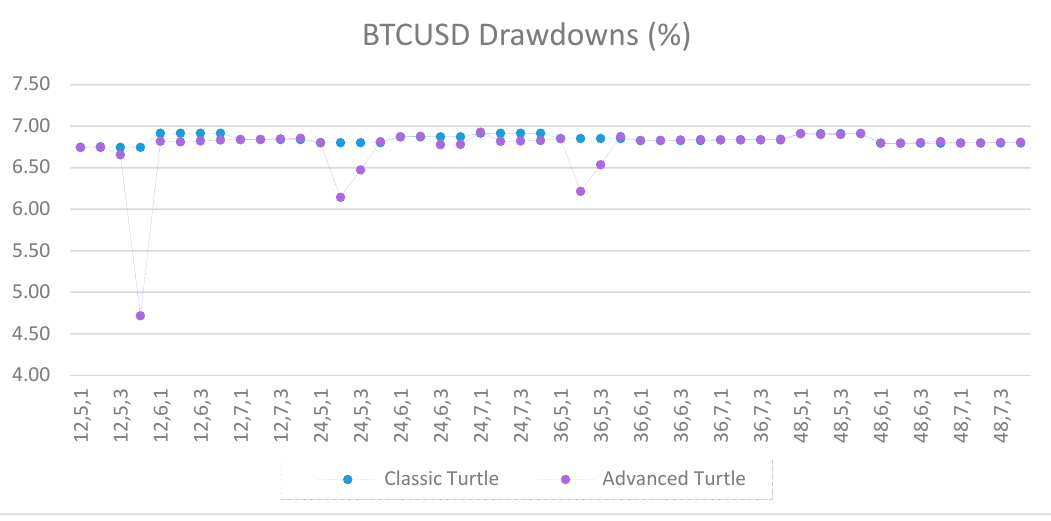
Figure A64. Drawdowns of BTCUSD as percentage of equity between the classic and the advanced Turtle systems for every combination of N, X, Y for the slow parameters (80, 160), where X ≥ 5.